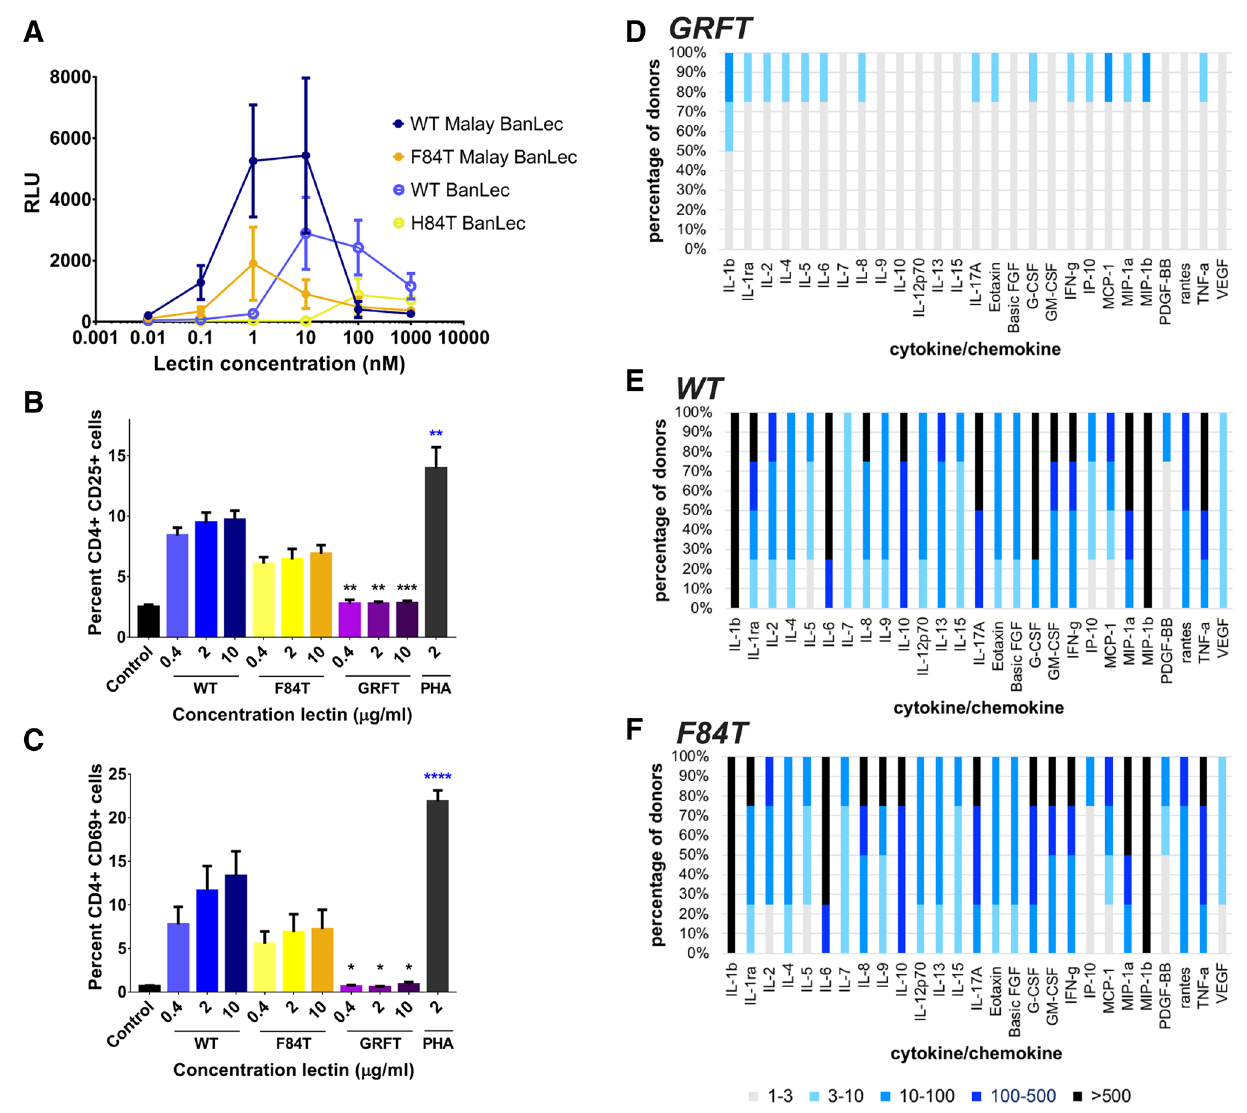
Figure 3. F84T Malay BanLec is less mitogenic than is WT Malay BanLec. ( a ) BrdU incorporation into PBLs. PBLs from healthy human donors were treated with a range of concentrations of WT or F84T Malay BanLec, or WT or H84T BanLec for 3 d and then BrdU incorporation over 18 h was measured by chemiluminescent ELISA. Data are representative of two independent experiments using cells from two donors, with data from one donor shown. Error bars represent the SEM of triplicate values. ( b , c ) Activation markers in lectin-treated peripheral blood mononuclear cells (PBMCs). PBMCs from three healthy human donors were treated with a range of concentrations of WT Malay BanLec (WT) or F84T Malay BanLec, griffithsin (GRFT), or PHA and the percentage of CD4 + CD25 + (B) or CD4 + CD69 + (C) cells assessed by flow cytometry. GRFT, known to be virtually non-mitogenic, serves as the negative control, whereas PHA serves as the positive control. Bars represent the average values from the three donors and error bars the SEM. Black asterisks indicate statistically significant differences between the means in the GRFT group and the corresponding means in the WT group. Blue asterisks indicate statistically significant differences between the mean in the PHA group and the mean in the control group. * P < 0.05, ** P < 0.01, **** P < 0.0001. ( d – f ) Cytokine/chemokine secretion in lectin-treated PBMCs. PBMCs from multiple healthy donors were treated with GRFT ( d ), WT ( e ), or F84T Malay BanLec ( f ) and supernatants collected for analysis of expression of various cytokines and chemokines by BioPlex assay. Results are expressed as the percentage of PBMC donors whose stimulated PBMCs express the indicated fold increase values of cytokine/chemokine concentrations with respect to untreated PBMCs. The figure was generated using GraphPad Prism 7 (https ://www.graph pad.com/scien tific -softw are/prism /) and